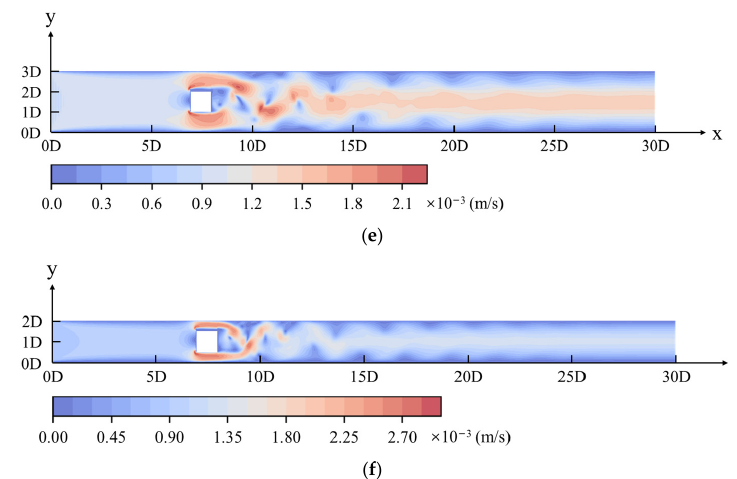
Figure 5. Flow pattern around a square cylinder under different boundary constraint degrees when R e = 400. ( a ) G / D = 5.5; ( b ) G / D = 3.5; ( c ) G / D = 2.5; ( d ) G / D = 1.5; ( e ) G / D = 1.0; and ( f ) G / D = 0.5.